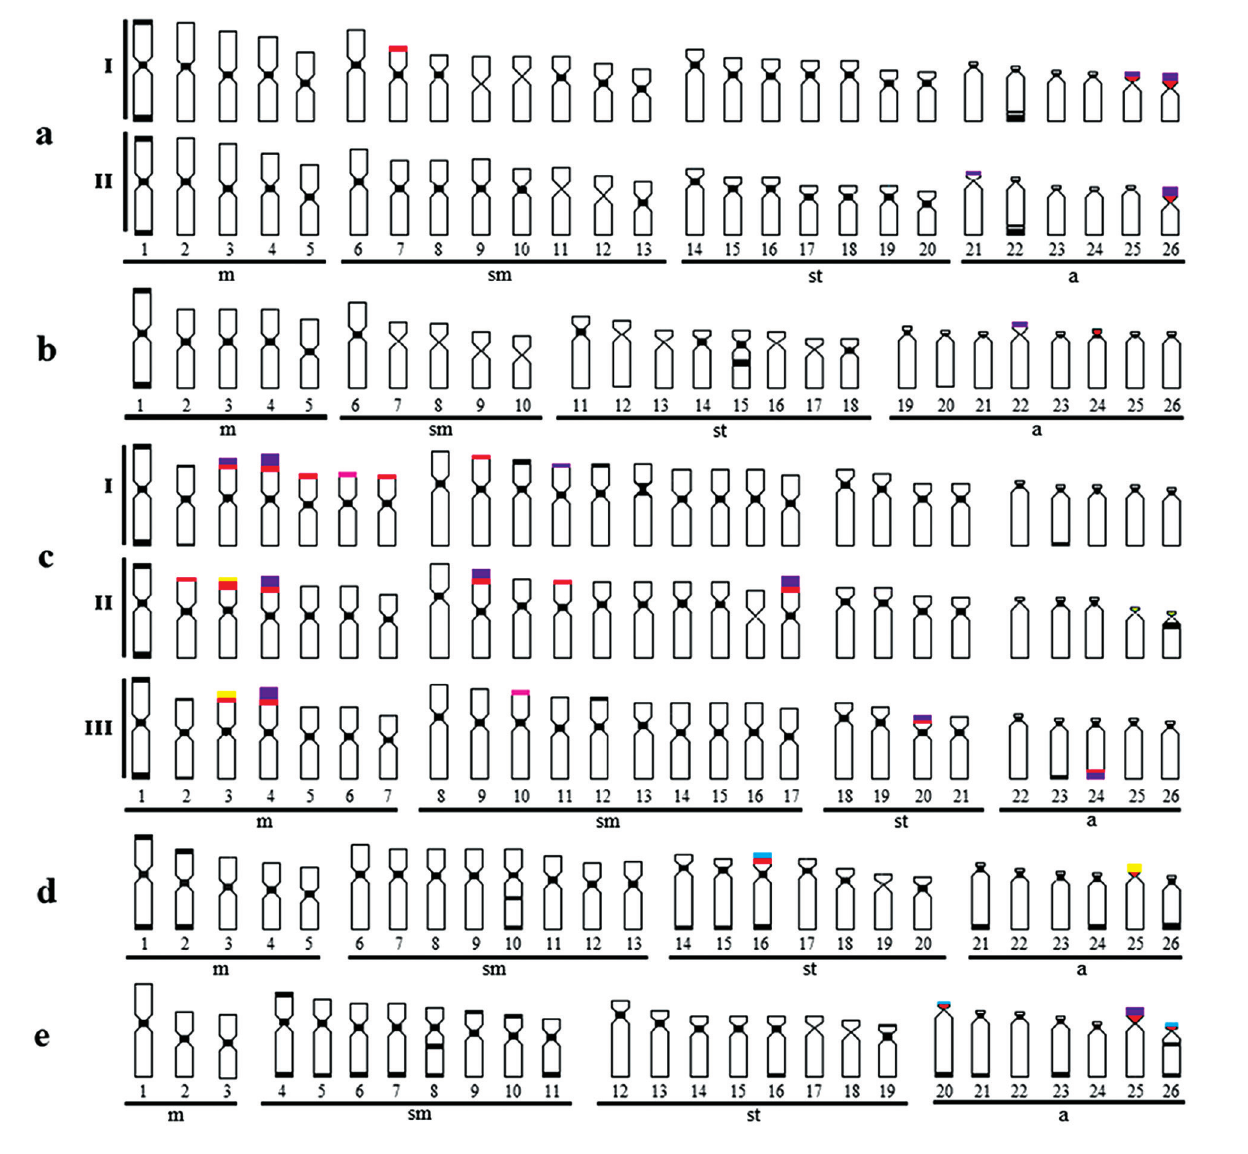
Fig. 4. Idiogram comparing the cytogenetic characteristics of the four Bryconamericus species. a B. aff. iheringii (Ijuí River): patterns I and II; b B. aff. iheringii (Iguaçu River); c B. coeruleus : patterns I, II and II; d B. cf. ecai ; e B. cf. eigenmanni